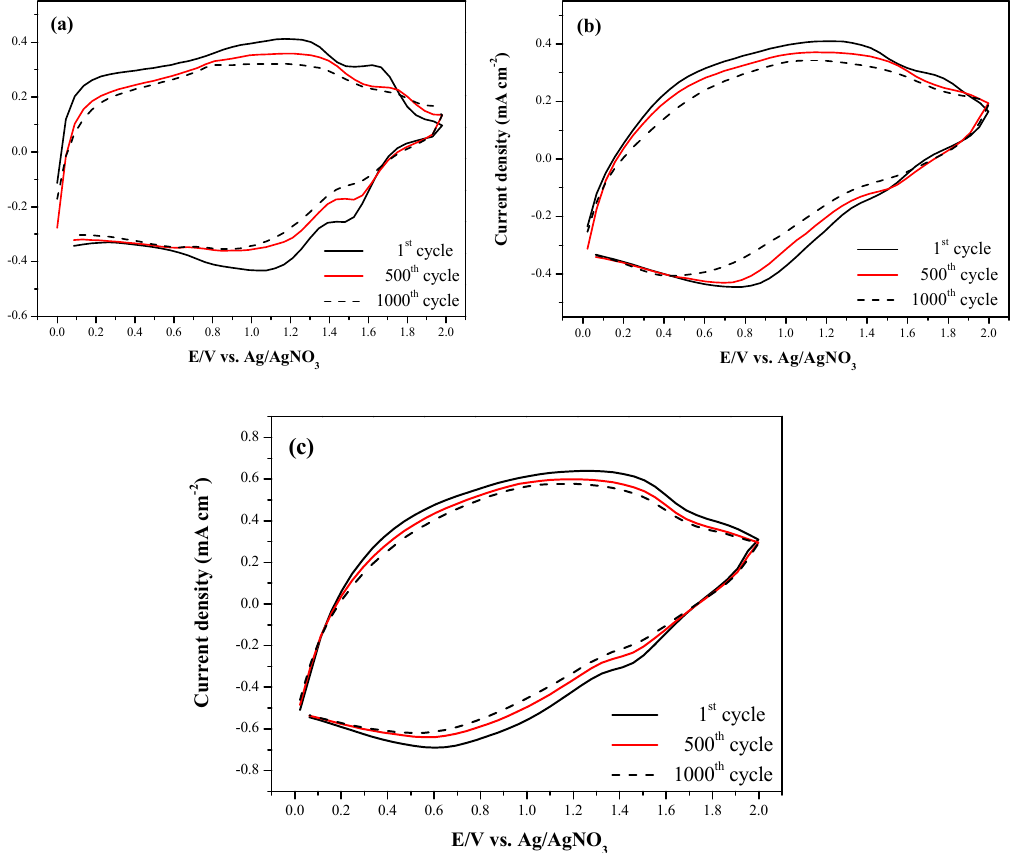
Figure 11. Cyclic voltammograms of: ( a ) PBCz/double-layer PEDOT-PSS ECD; ( b ) P(BCz- co -ProDOT)/ double-layer PEDOT-PSS ECD; and ( c ) P(BCz- co -ProDOT)/triple-layer PEDOT-PSS ECD as a function of repeated scan with a scan rate of 500 mV · s − 1 between 1 and 1000 cycles.